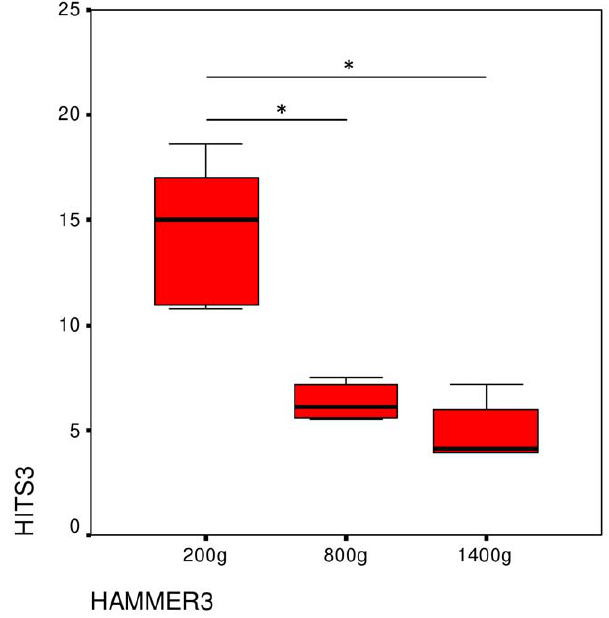
Figure 7. Median number of strikes needed to crack open a nut in Experiment 3. Also shown are the IQR and significance tests.